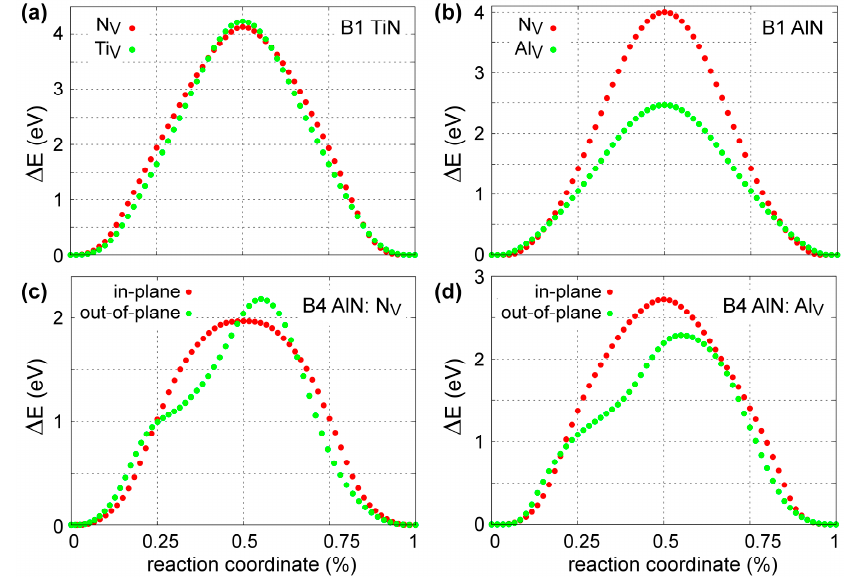
Figure 7. Minimum energy pathways for migration of N (N V ) and metal (Ti V , Al V ) vacancies among nearest-neighbor sites in the anion (for N V ) and cation (for Ti V and Al V ) sublattices in ( a ) B1-TiN, ( b ) B1-AlN, and ( c , d ) B4-AlN. For B4-AlN structures, we studied vacancy migration both within, as well as across, the (0001) plane.